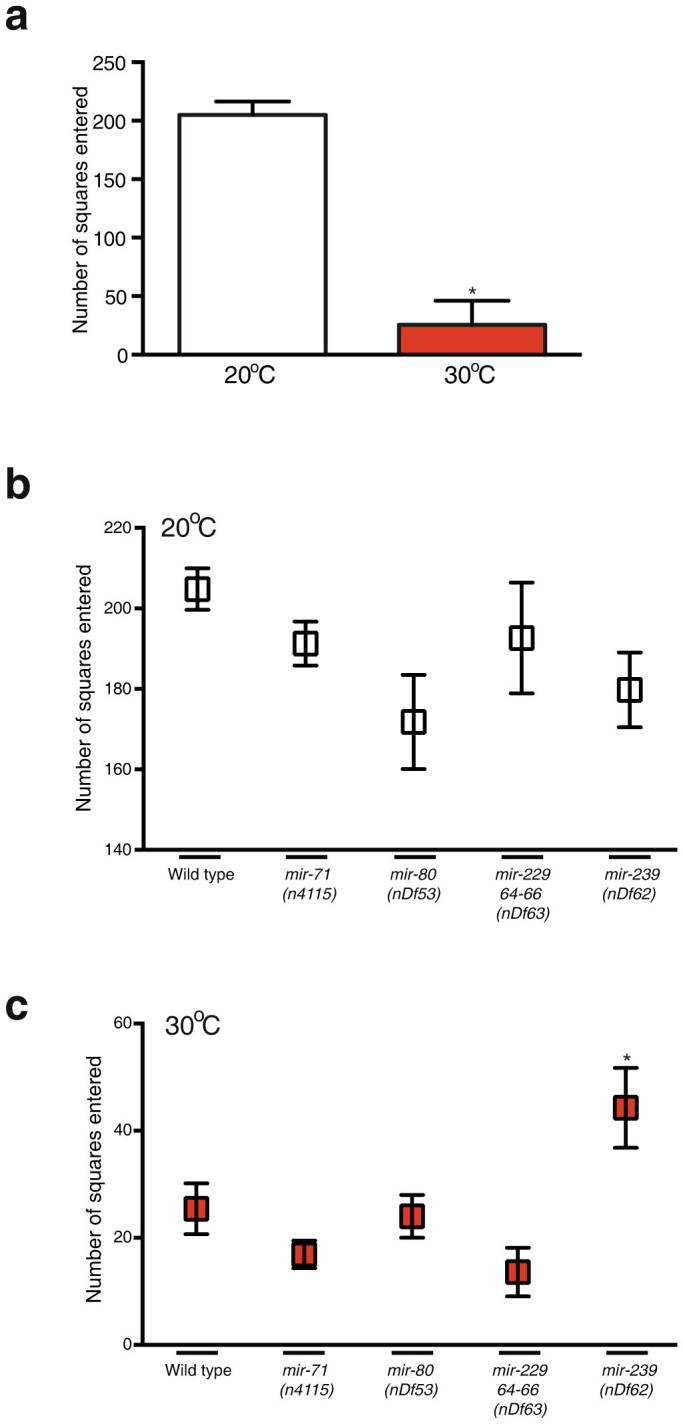
C. elegans Reduces Motility in Elevated Temperature.(a–c) Synchronized L4 animals were exposed to 20°C or 30°C for 6 hrs, followed by 16 hrs on plates fully covered with bacteria to assay motility. Data is presented as number of squares the worm crossed within 16 hrs out of a total of 240 squares. Data are presented as means ± SEM and statistical significance was assessed by ANOVA followed by Dunnett's multiple comparison test n > 13, *p < 0.05. The wild-type worms presented in (a) are the same as for (b) for illustration.